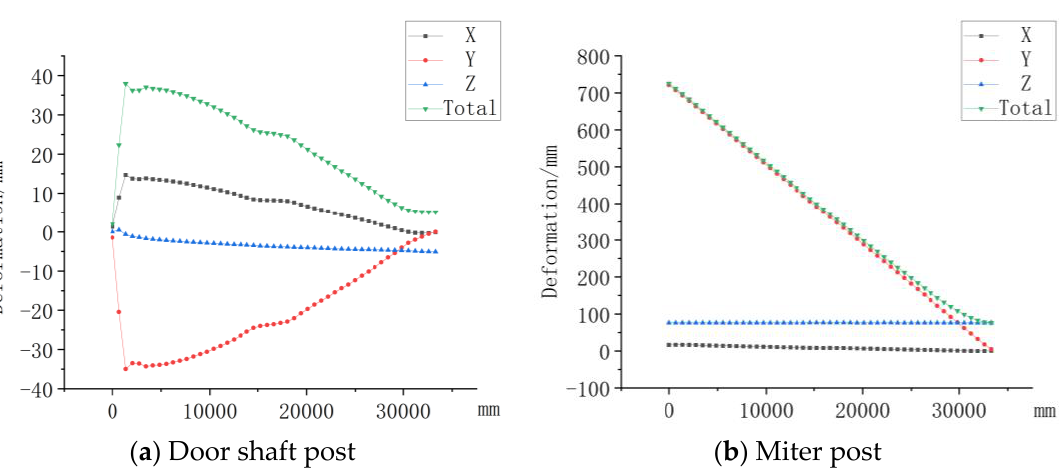
Figure 15. ( a ) Deformation in different directions of the shaft column, ( b ) Deformation of the mitered column of the gate without the back tie rod under the door-opening condition.